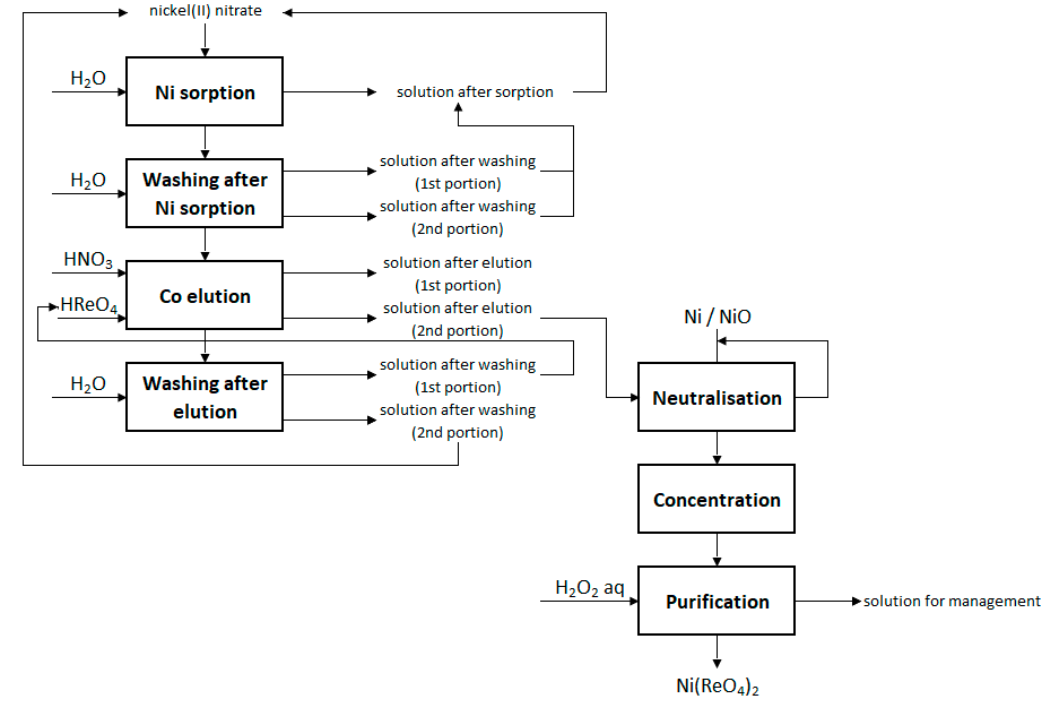
Figure 3. Scheme of Ni(ReO 4 ) 2 preparation.